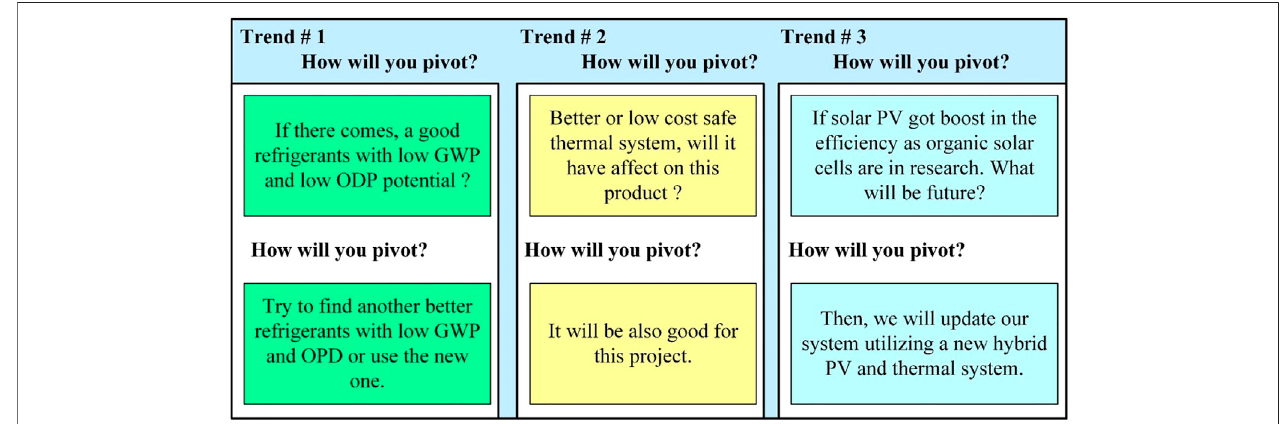
FIGURE 14 | Pivots and their solutions (Pivot